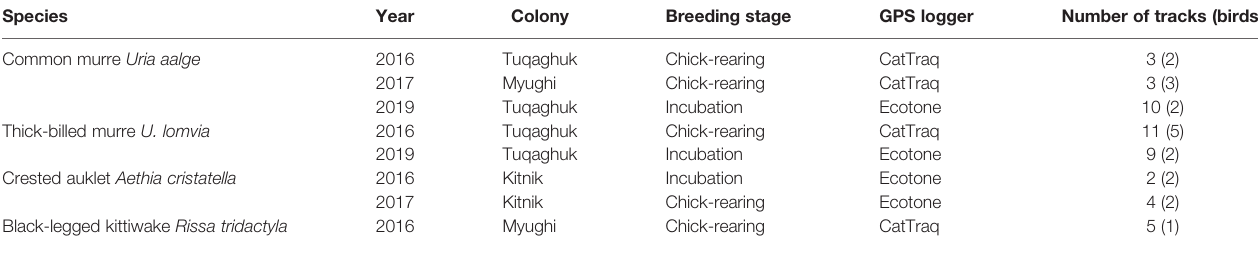
TABLE 1 | Summary of tracks available per seabird species, study year, breeding stage and model of tracking unit. Species Year Colony Breeding stage GPS logger Number of tracks (birds) Common murre Uria